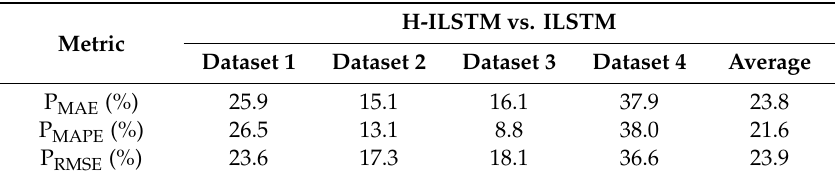
Table 13. The promoting percentages of the ILSTM model by the H-ILSTM model of the three-step prediction for the load datasets 1–4.